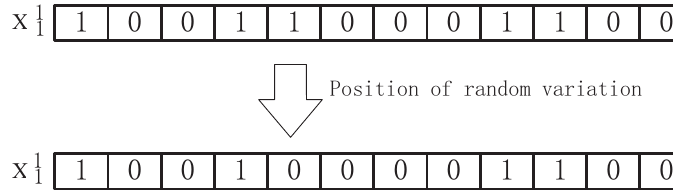
Figure 3. Schematic diagram of binary code